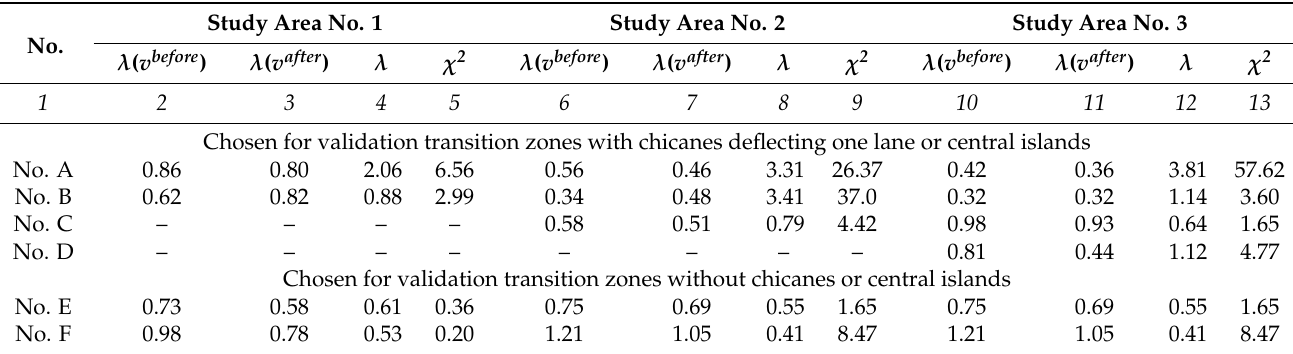
Table 3. Results of standard statistical tests in additional transition zones accepted for validation (in relation to 85th percentile speed). Goodness-of-fit K–S test and Two–sample K–S test λ α = 1.36 ( α = 0.05), Median test χ α 2 = 3.84 ( α = 0.05).